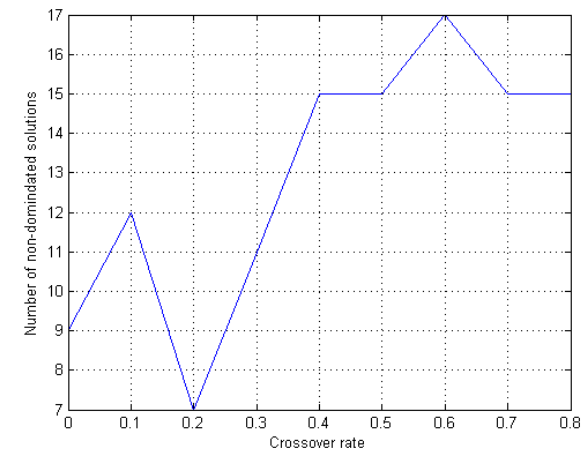
Figure 5. Number of nondominated solutions vs. mutation rate vs. crossover rate.